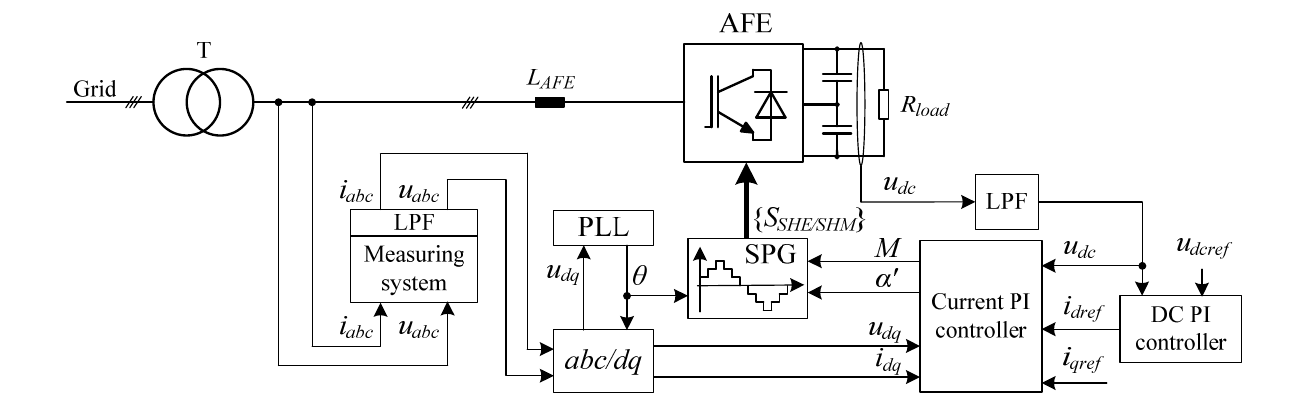
Figure 6. Circuit diagram of the AFE closed-loop control system.